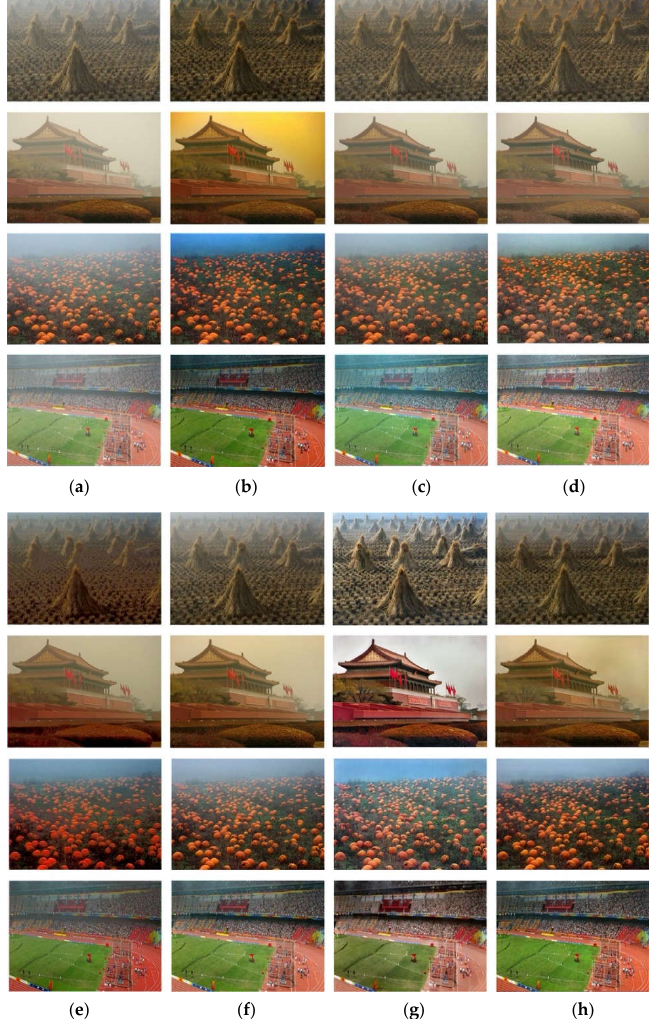
Figure 7. Dehazing effect of different dehazing algorithms on real-world images. ( a ) Input image; ( b ) DCP [12]; ( c ) CAP [13]; ( d ) DehazeNet [16]; ( e ) AOD-Net [18]; ( f ) MSBDN [21]; ( g ) DA-dahazing [26]; ( h ) Ours.